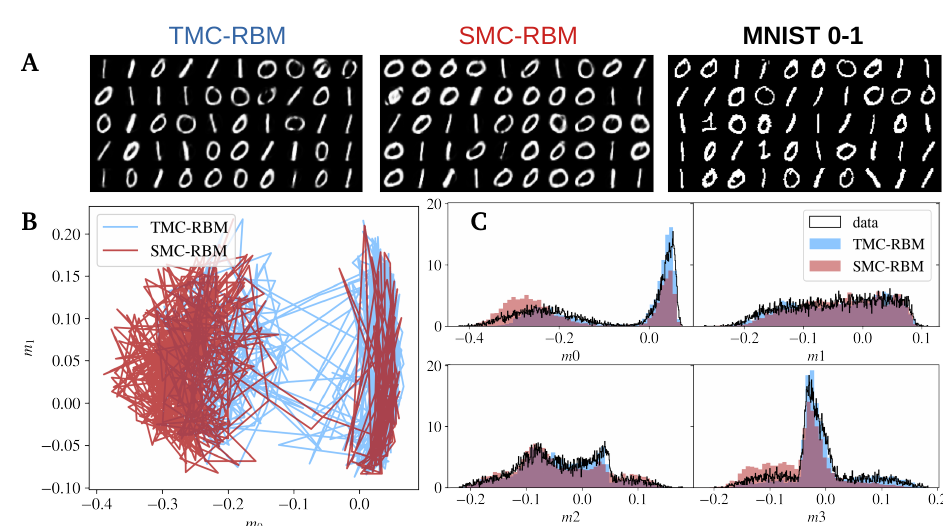
Figure 9: For a TMC-RBM and a SMC-RBM, both trained for 1001 parameter up- dates with the same learning rate γ = 0.01 and the same k = 10, we show: A: 50 equilibrium samples generated (with each model) and compared to 50 samples of the original MNIST dataset. In order to ensure equilibration, we performed 10 7 SMC sweeps prior to imaging B: For both machines, we show the scatter plot of the SMC dynamical trajectories projected along the first two directions: m sweeps, for 5 · 10 5 SMC sweeps. It can be clearly seen that the sampling of the SMC- RBM is slower, since there are fewer jumps (red curve) between digits 0 and 1.